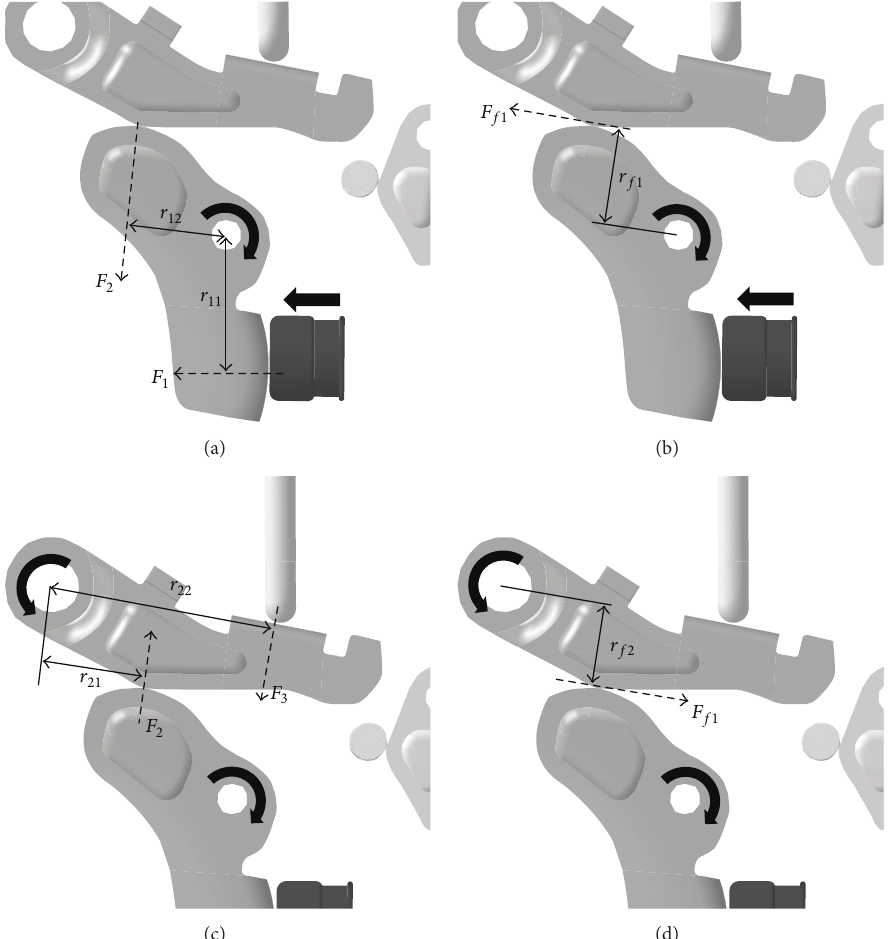
Figure 11: Free body diagram for solving moment at step 4: (a) free body diagram showing force of bracket release, (b) free body diagram showing friction force of bracket release, (c) free body diagram showing force of pop-up guide by force, and (d) free body diagram showing friction force of pop-up